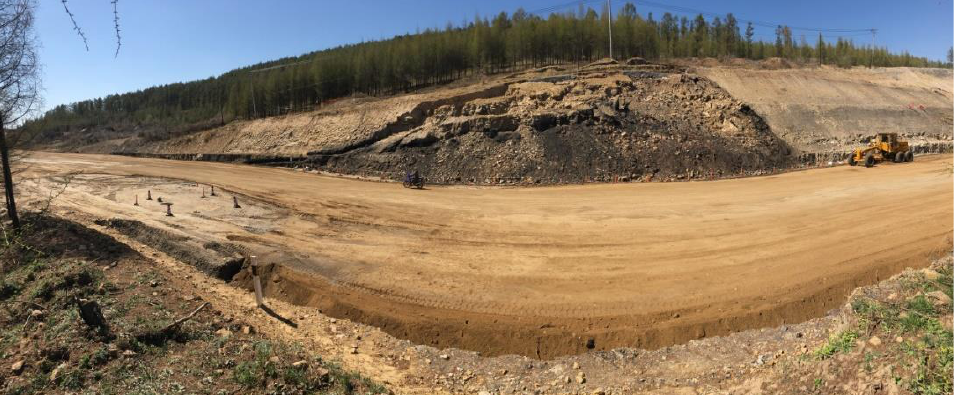
Figure 6. Overall instability and collapse of a slope containing a coal seam in a goaf. The road line is a straight line in reality, which can be viewed in conjunction with Figures 7 and 8. Because of the wide angle of the camera, the road in the picture is curved.